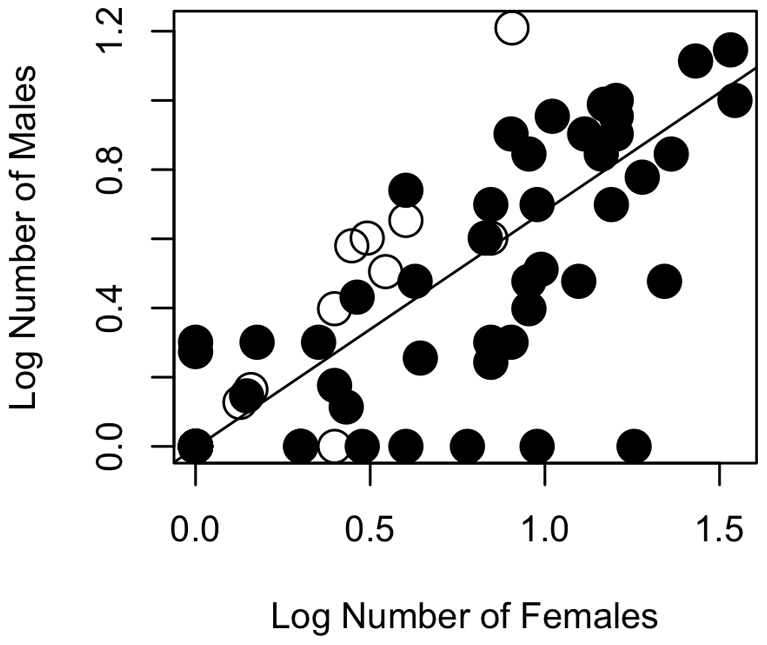
Association between number of males and number of females in primate groups.Data are log10 transformed. The regression slope of 0.68 was obtained as the mean of the posterior probability distribution from the MCMC analysis (Table 1, Fig. 2) and was forced on to the raw data. The intercept of −0.0035 was also obtained from the phylogenetic analysis. Haplorhines are represented with black circles and strepsirrhines with open circles.